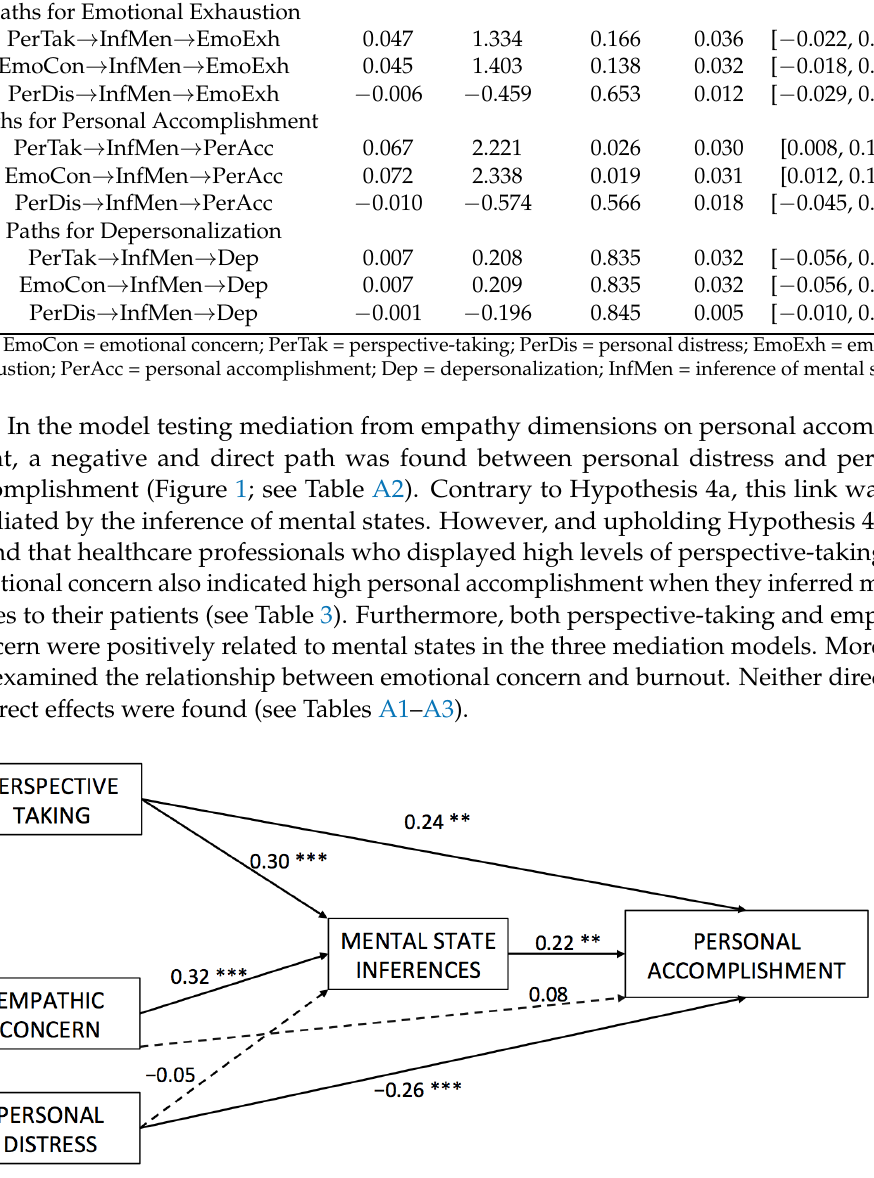
Figure 1. Direct paths from dimensions of empathy to personal accomplishment through the inference of mental states. ** p < 0 .01, *** p < 0.001. Table 3. Indirect paths from dimensions of empathy to burnout dimensions through the inference of mental states for the models of multiple mediation analyses.